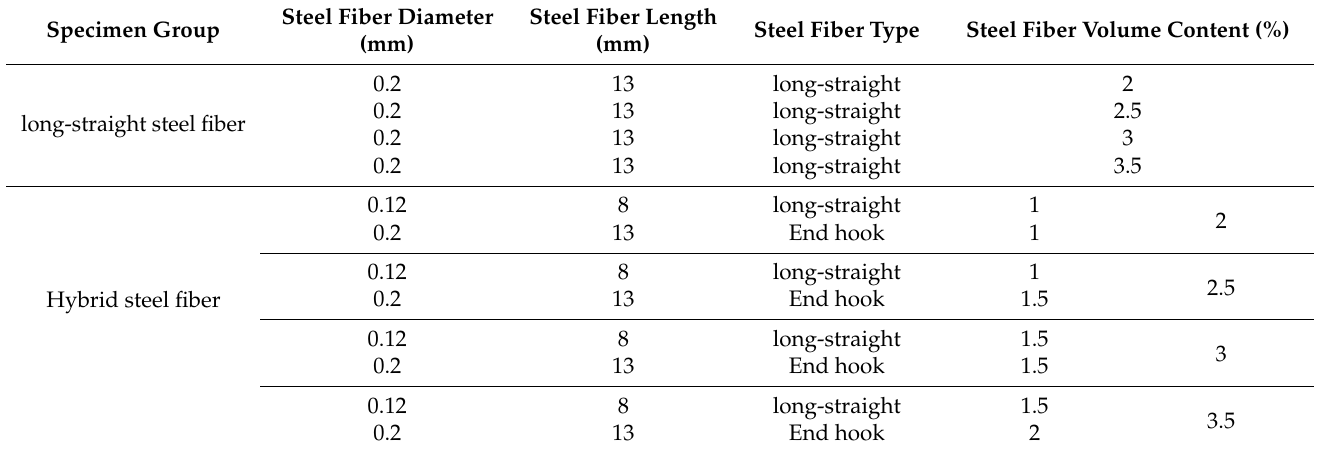
Table 1. Design of steel fiber composite parameters.